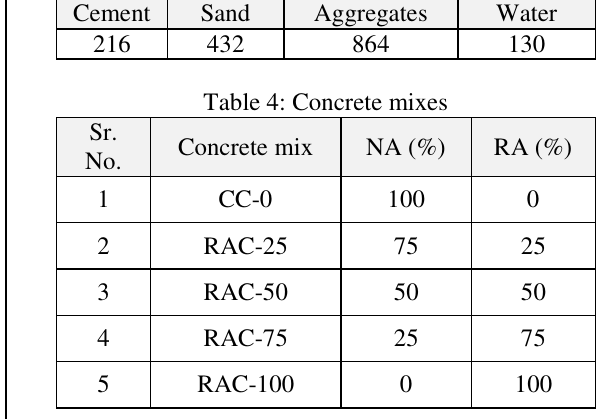
Fig.2: Recycled Aggregates (RA) Table 3: Mix proportion of concrete (values in kg/m 3